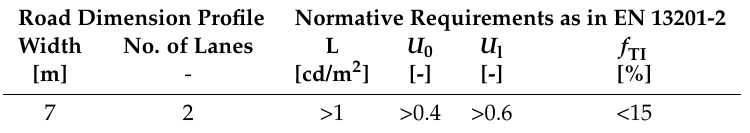
Table 3. Road dimension and normative lighting system requirements as in EN 13201-2. Road Dimension Profile